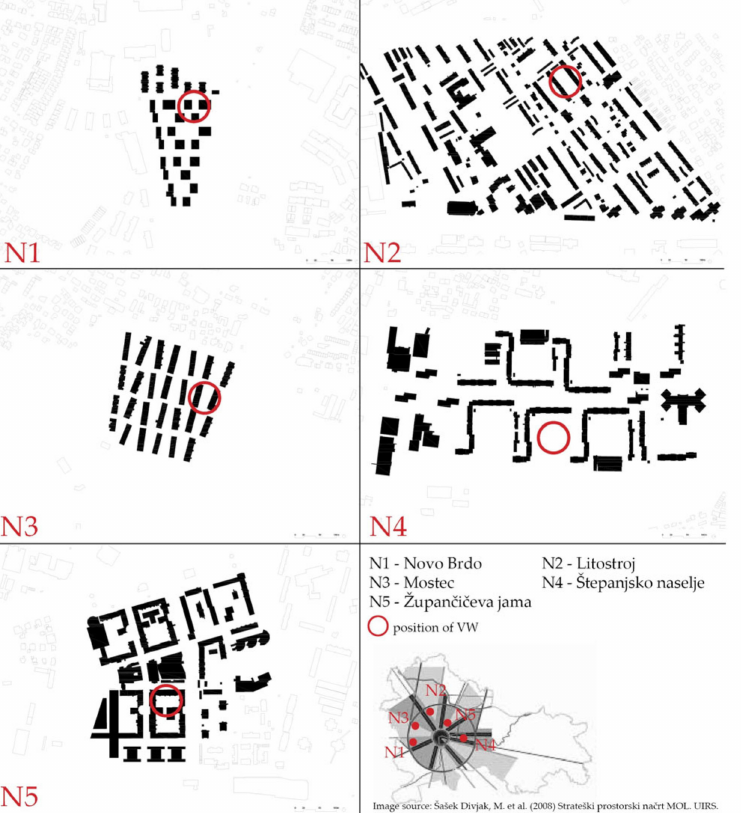
Figure 1. Five major residential neighborhoods in the city of Ljubljana and position of neighborhoods in strategic abstraction [66] of